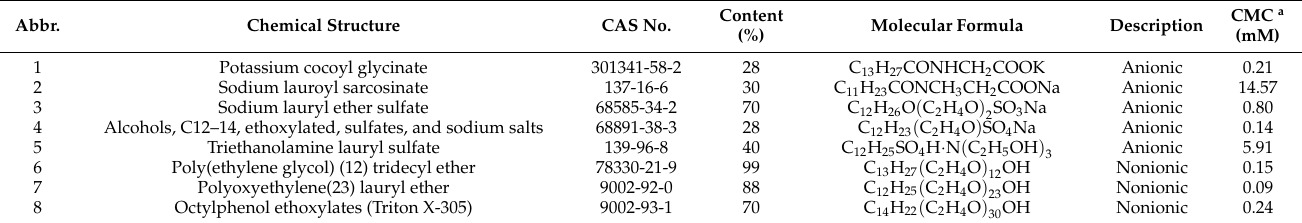
Table 1. Properties of the selected surfactants used in this